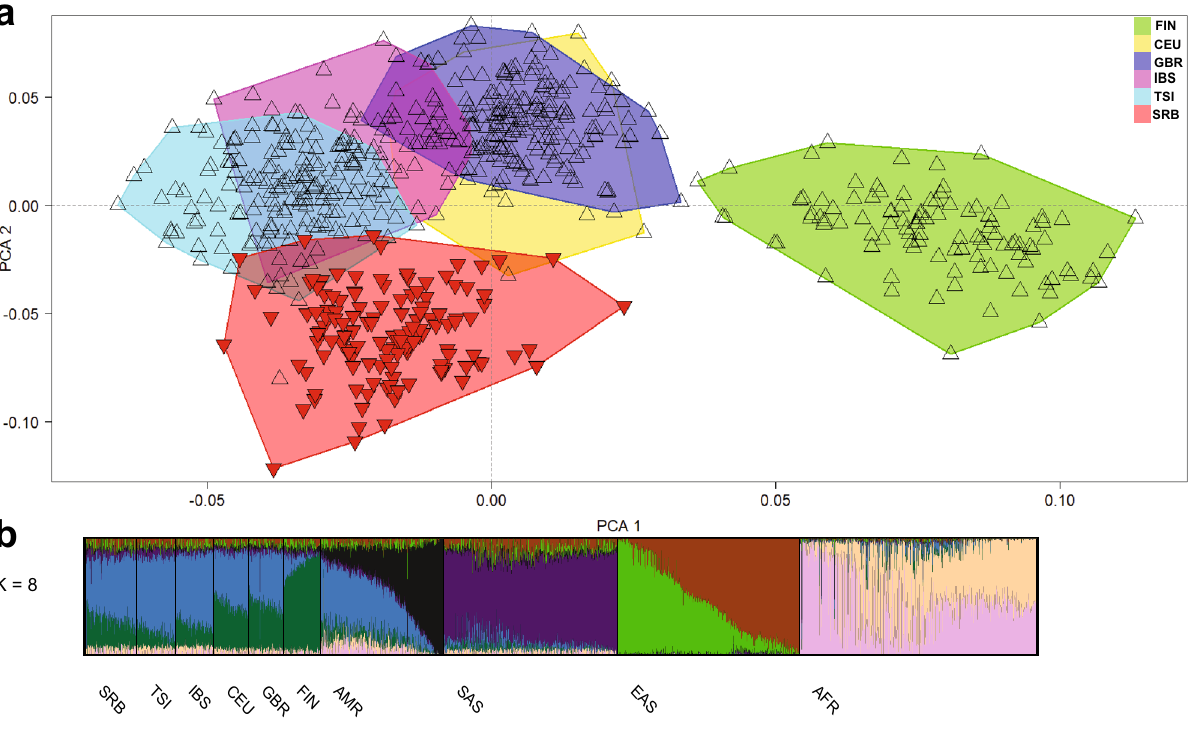
Figure 4. ( a ) Principal component analysis (PCA) of the Serbian population sample. The PCA of the study data combined with The 1000 Genomes Project Phase 3 data of European populations: SRB Serbian, TSI Toscani in Italia, IBS Iberian population in Spain, CEU Utah Residents with Northern and Western European Ancestry, GBR British in England and Scotland, FIN Finnish in Finland. The figure represents the overlap of convex hulls of the population of Serbia with European populations of 1kGP, without the four outliers found in the population of Serbia while performing PCA. ( b ) Population structure analysis by applying the ADMIXTURE 38 . Distribution of the ancestry components for K = 8. Each bar plot represents the average ancestry proportions across individuals from the Serbian (SRB) and populations from 1kGP. Population codes: SRB Serbian, TSI Toscani in Italia, IBS Iberian population in Spain, CEU Utah Residents with Northern and Western European Ancestry, GBR British in England and Scotland, FIN Finnish in Finland, AMR American Admixed, SAS South Asian, EAS East Asian, AFR